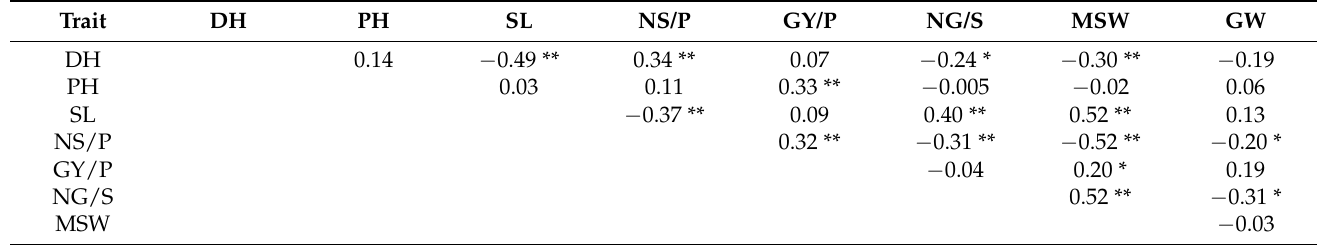
Table 2. Genotypic correlation among traits in the base population (F6